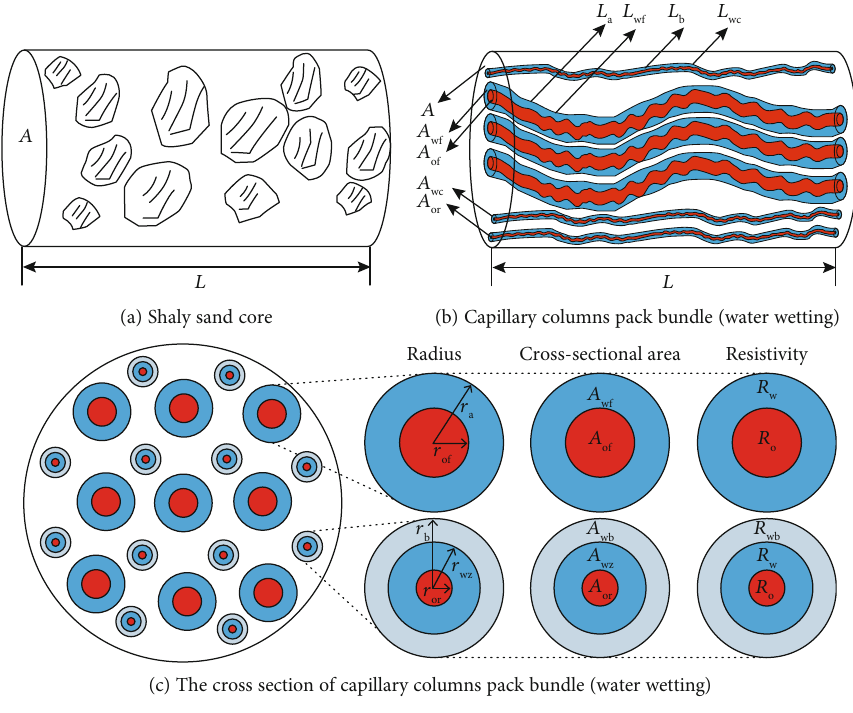
Figure 1: Capillary bundle